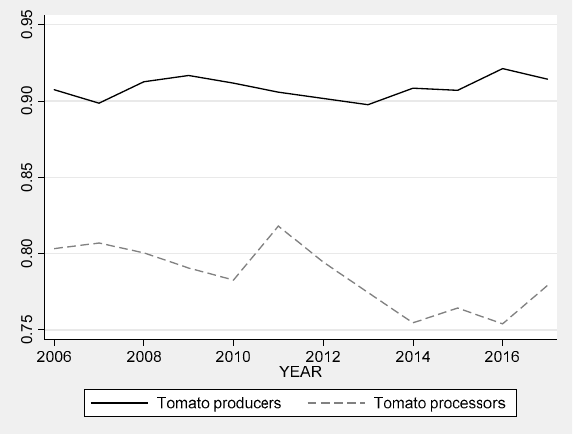
Figure 5. Development of technical efficiency. Source: authors’ calculations.